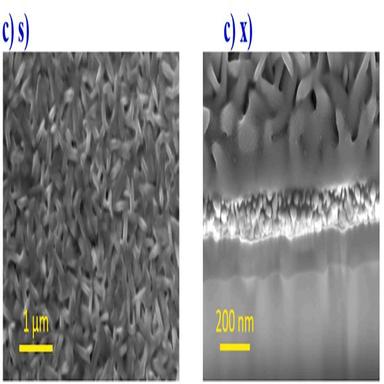
s) surface and x) cross-section SEM images obtained at 30 kV with 50 k magnification of BZT thin films deposited at: a) 350º C, 60 min; then b) annealed at 550º C, 60 min in O2. Deposited at c) 550º C, 50 min with O2:Ar.= 50%.